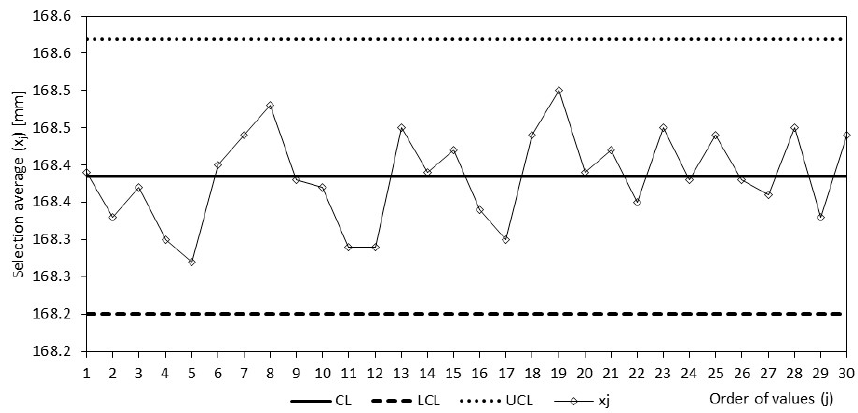
Figure 9. Shewhart control chart individual values for the width parameter, second day.